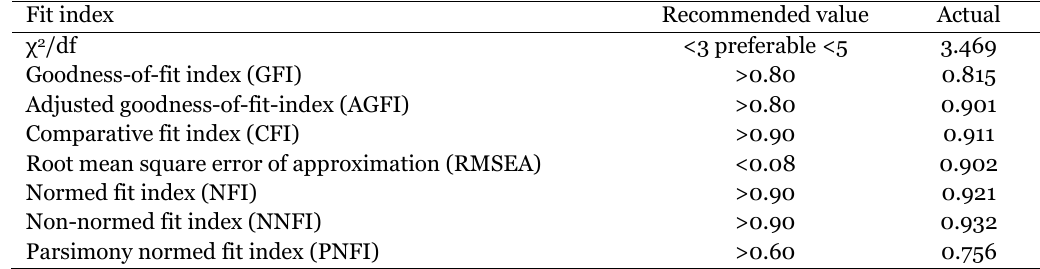
Fit Indices for the Structural Equations